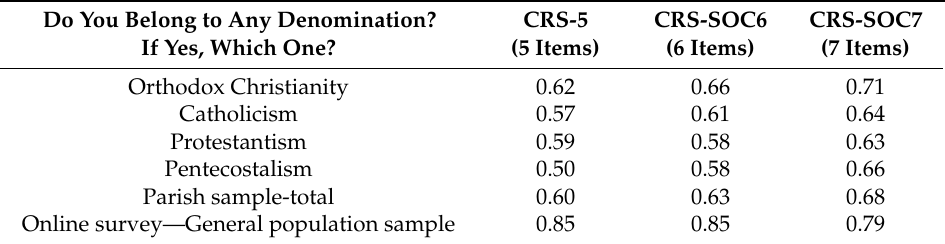
Table 2. Cronbach’s Alphas for the short version of the Centrality of Religiosity Scale (CRS-5) and two versions of the modified Centrality of Religiosity Scale